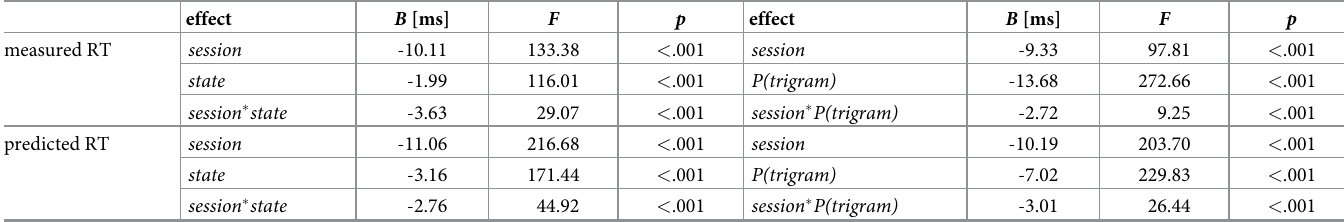
Table 2. Repeated measures ANOVAs in sessions 1–8. In the left set of columns, the trial type is defined as the state and in the right set of columns it is defined as P (trigram).